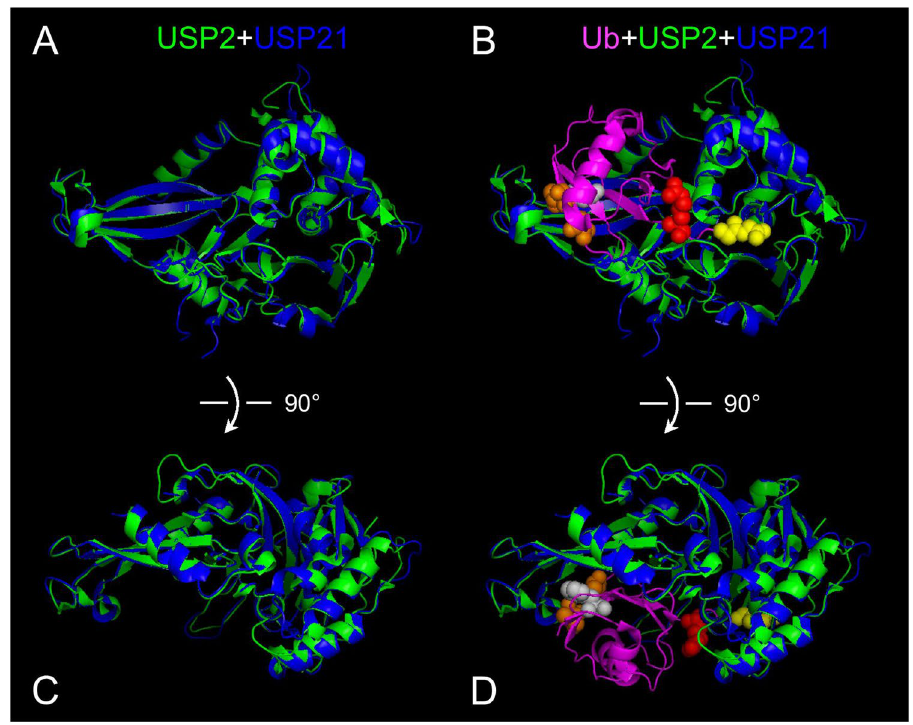
Figure 7. The superposition of USP2 with USP21. ( A ) The 3-D structure of USP2-core (PDB ID: 2HD5) in green was superimposed with the 3-D structure of USP21 (PDB ID: 3MTN) in blue by using PyMOL software. The overall structure resembles a cupped hand comprising a conserved Fingers-Palm-Thumb architecture. ( B ) The Ub-based suicide probe (shown in magenta) was added to the superimposed images of USP2-core and USP21-core. The C-terminal di-glycine motif was shown in yellow, Arg-72 was shown in red, Thr-12 and Thr-14 were shown in orange, and Phe-4 was shown in grey. For better recognition of the indicated residues, they were also noted as spheres. ( C and D ) The superimposed images of ( A and B ) were rotated 90 degree along with the x-axis to reveal another view angle and the close interaction between the N-terminal region of Ub and the tip of the Fingers of